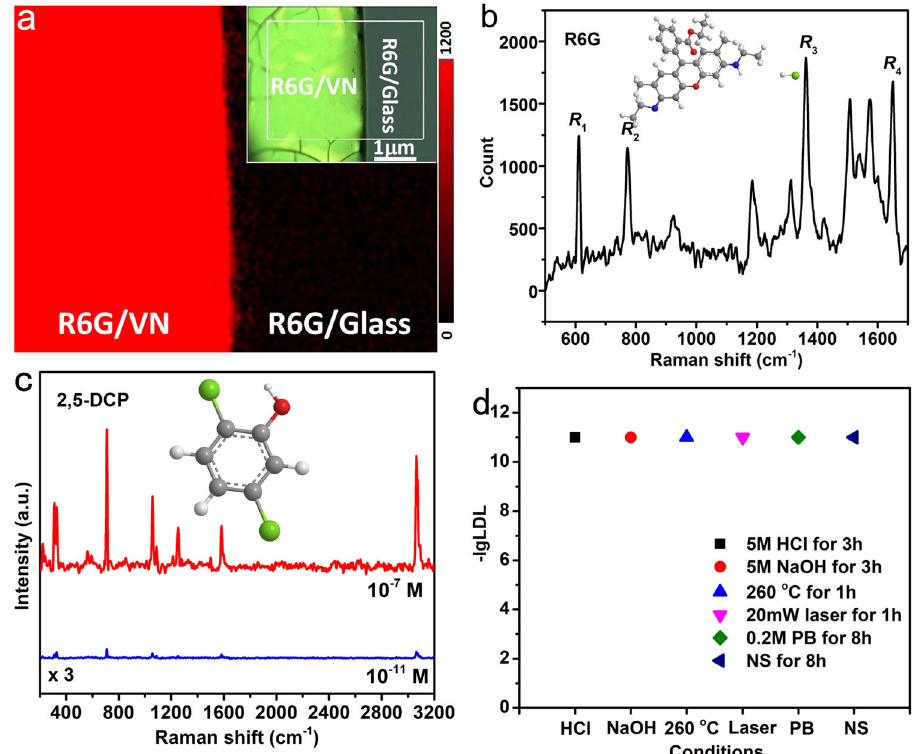
Fig. 7 Enhanced Raman scattering effect of the 3D porous VN. a Raman mapping near an edge of a R6G/VN layer, inset: the corresponding optical picture. b Raman spectrum of 10 − 8 M R6G obtained on the 3D porous VN substrate, inset: molecule structure of R6G. Laser power: 0.5 mW; Integration time: 7 s. c Raman spectra of 10 − 7 and 10 − 11 M 2,5-DCP obtained on the 3D porous VN substrate, inset: molecule structure of 2,5-DCP. Laser power: 0.5 mW; integration time: 5 s for 10 − 7 M and 60 s for 10 − 11 M. d High stability of VN